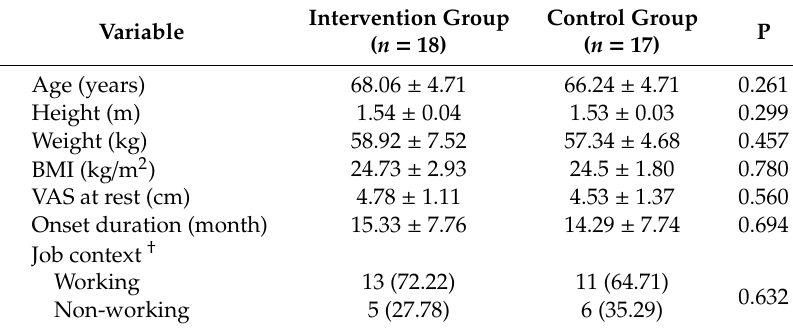
Table 1. General characteristics of the participants.